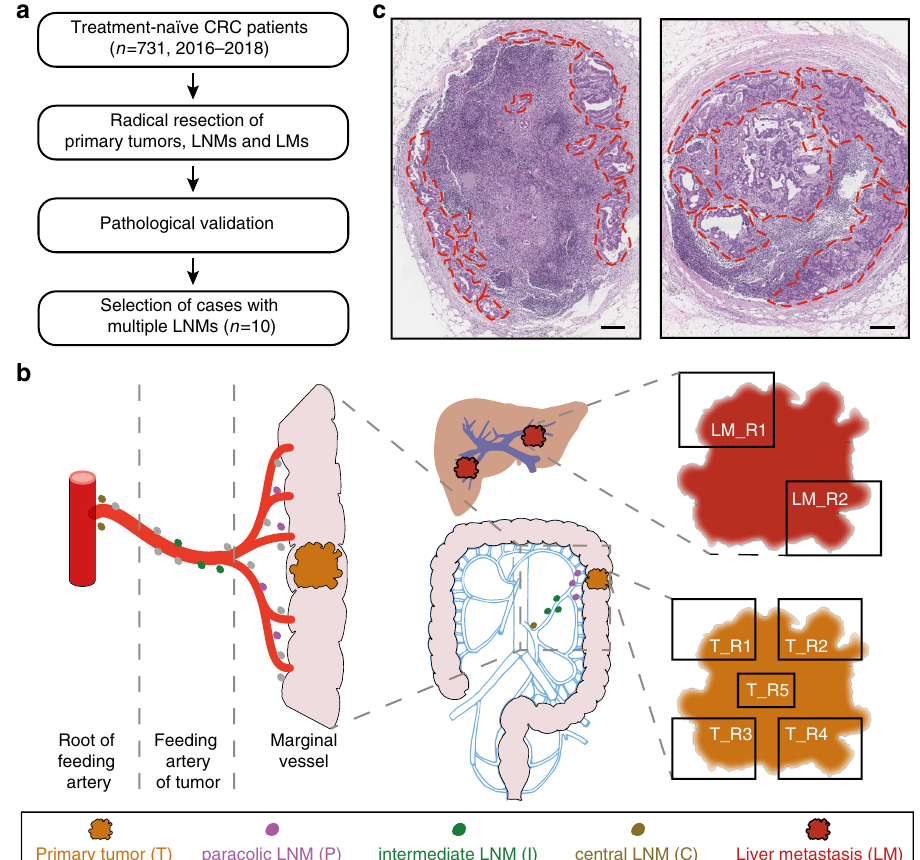
Fig. 1 Research strategy. a Case screening pipeline. Ten treatment-naive CRC patients with multiple LNMs were selected for this study. b Schematic showing CRC patients with LNMs and LMs. Spatial distribution and classi fi cation of paracolic (purple), intermediate (green), and central (brown) LNMs are shown on the left. Lymph nodes without tumor cell are colored gray. Multiple tumor regions (2 – 5 regions according to tumor size) were isolated from the primary tumor and liver metastasis. c Two representative whole-slide LNM sections stained with hematoxylin and eosin showing the tumor regions isolated by laser capture microdissection. Tumor regions (marked by red dashed lines) were marked by pathologists. Scale bar = 2.5